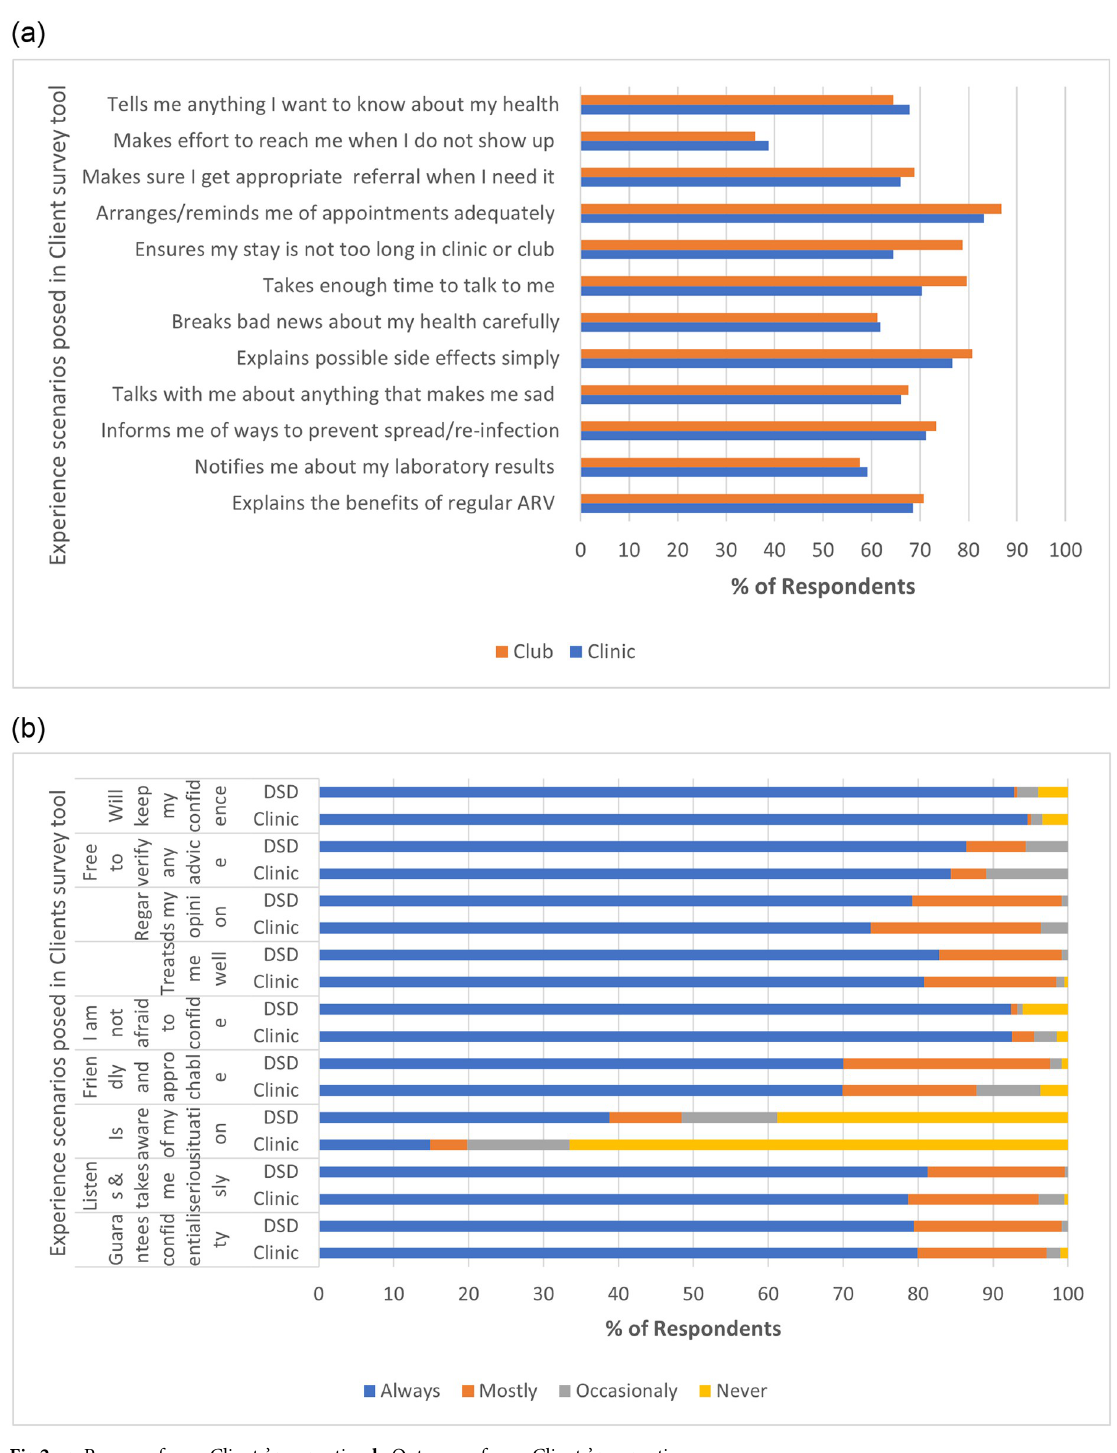
PLOS ONE | https://doi.org/10.1371/journal.pone.0265307 March 15,